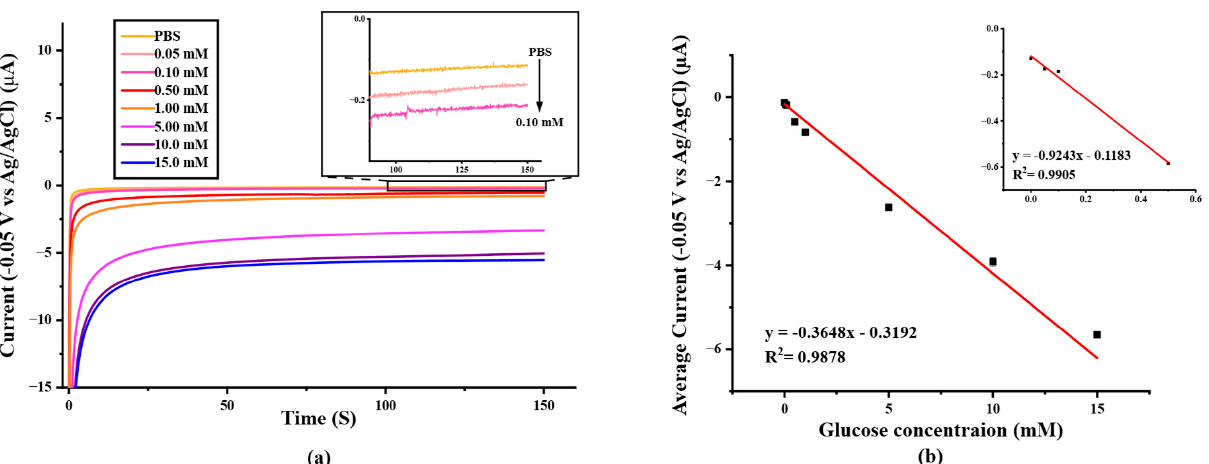
Figure 6. ( a ) Chronoamperometric response to the increasing of glucose concentration from 0–15 mM in 0.1 M PBS pH 7.4 (applied potential at − 0.05 V vs. Ag/AgCl), ( b ) A calibration curve with the linear range at 0.0–15.0 mM glucose in 0.1 M PBS (pH 7.4) (R 2 = 0.9878). Inset; a calibration curve with the linear range at 0.0–0.5 mM glucose. (R 2 = 0.9937) .